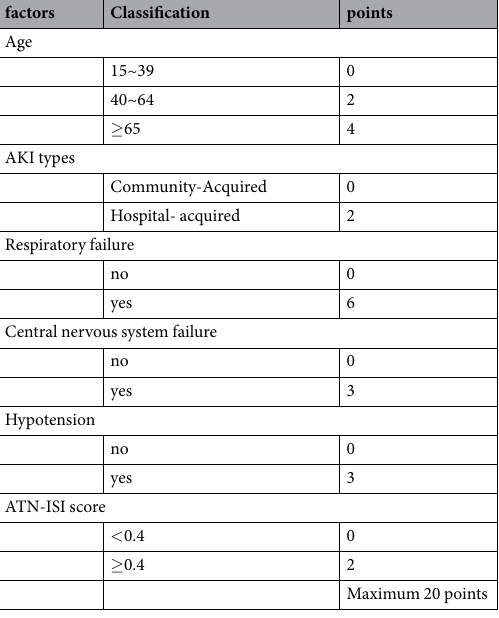
Table 5. Prognostic score of 90-day mortality in hospitalized patients with acute kidney injury.